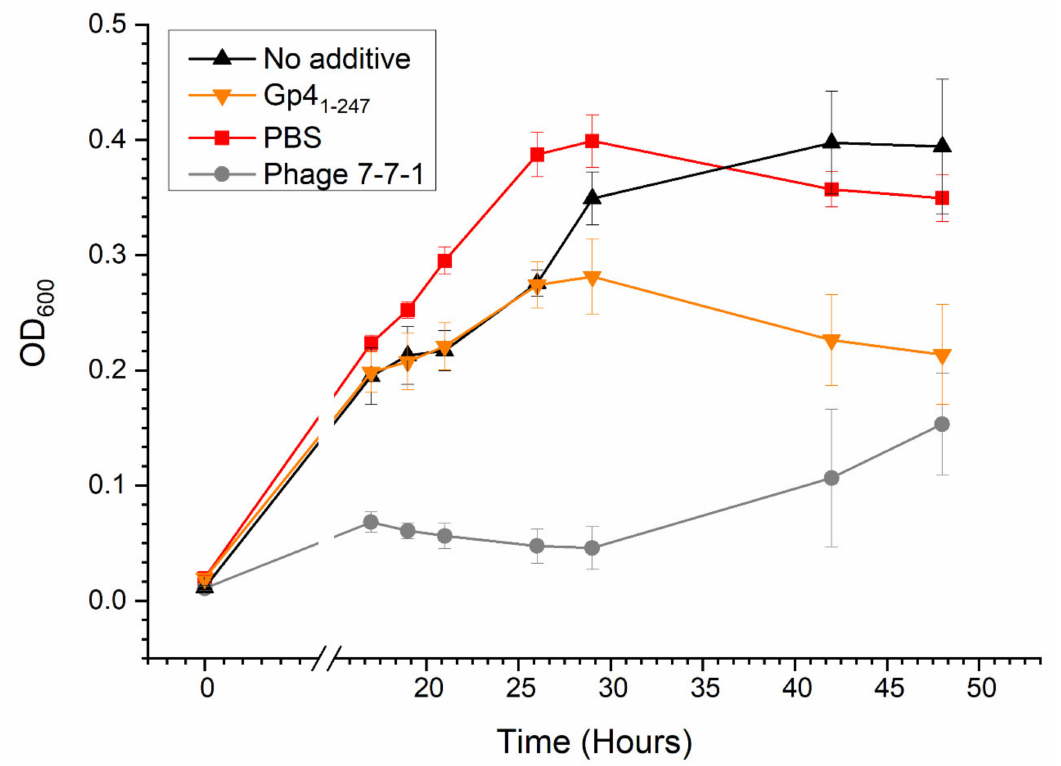
Figure 6. Growth curves for bacterial cultures under various conditions. Agrobacterium sp. H13-3 (OD 600 = 0.03) cells were deposited in 96-well plates and received 2 µ L of Gp4 1-247 (0.06 µ g/ µ L), PBS, phage 7-7-1 (MOI = 1), or no additive. Growth of the cultures was measured via OD 600 at 17, 19, 21, 27, 29, 42, and 48 h using a plate reader. Data are representative of 4 independent experiments conducted in quadruplicate and error bars reflective of standard deviation. Student’s t test for Gp4 1-247 and PBS or phage 7-7-1 at 42 and 48 h, p <